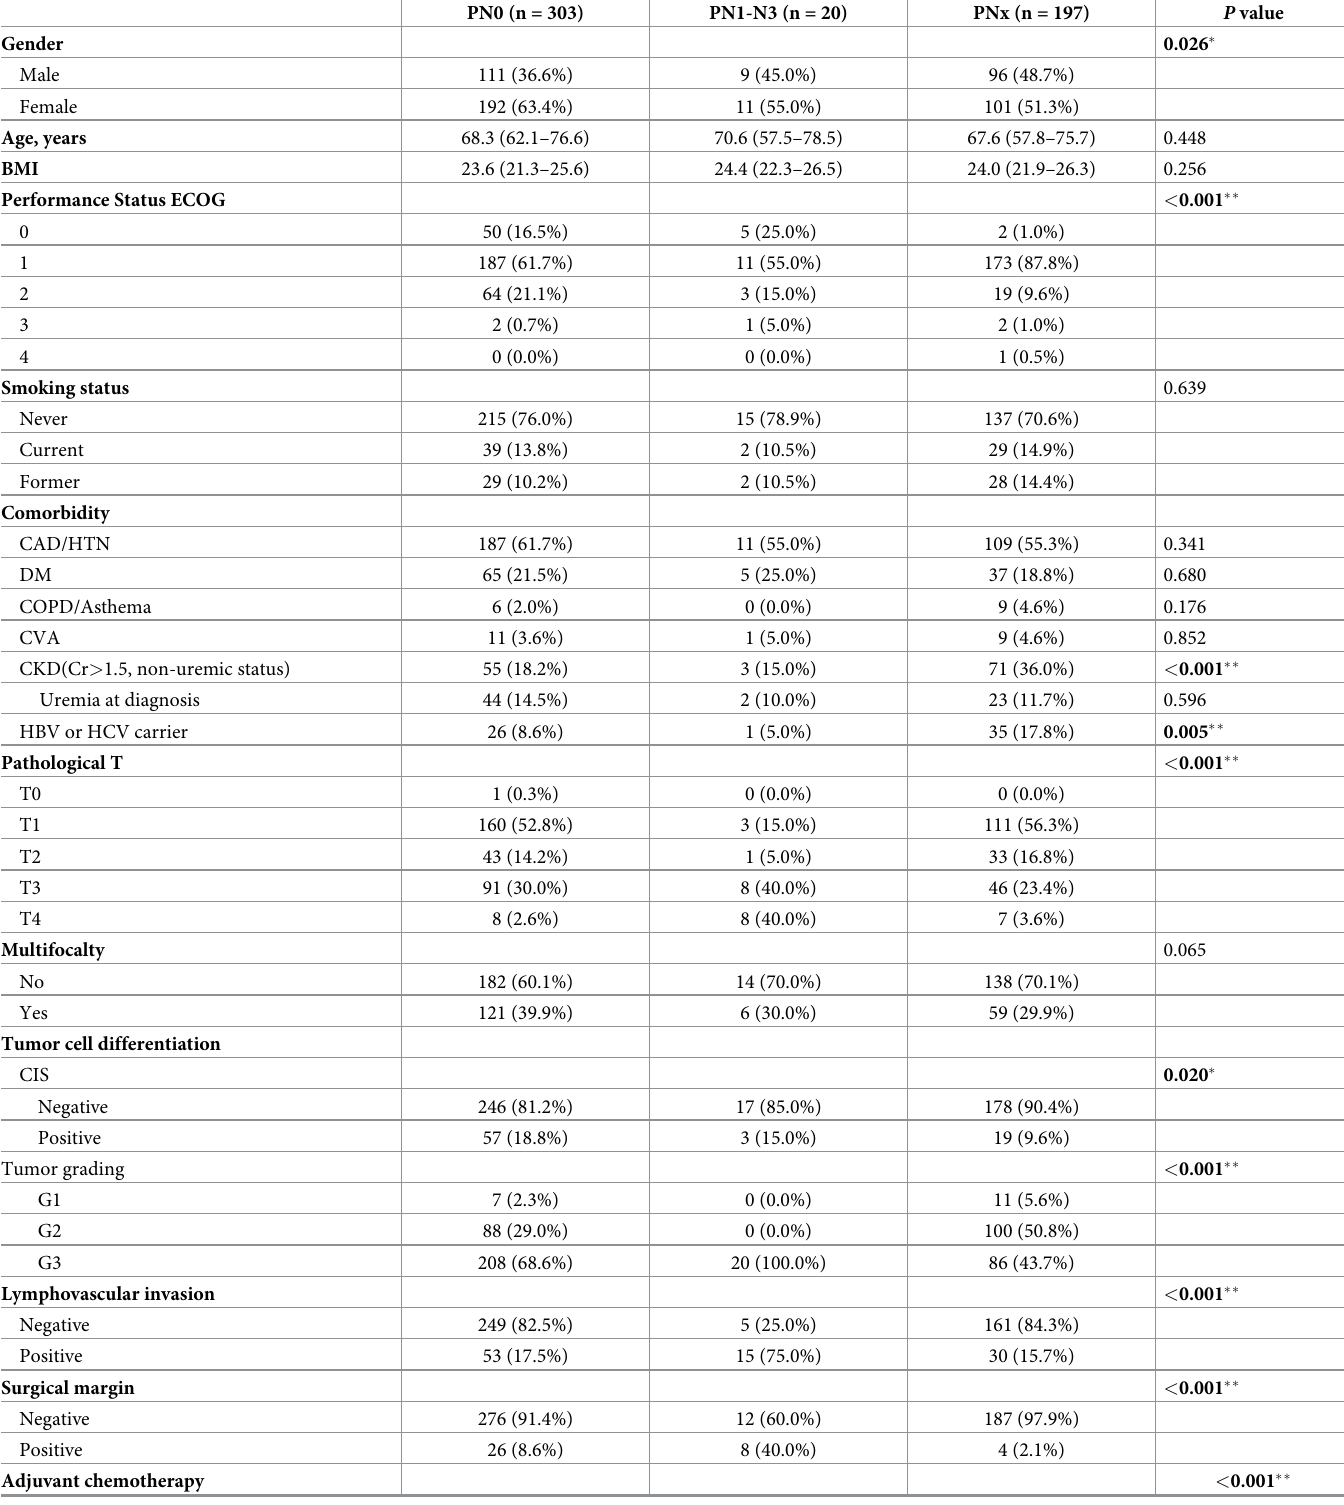
Table 1. Association of LND status and clinic-pathological characteristics of patients undergoing RNU with BCE for cN0